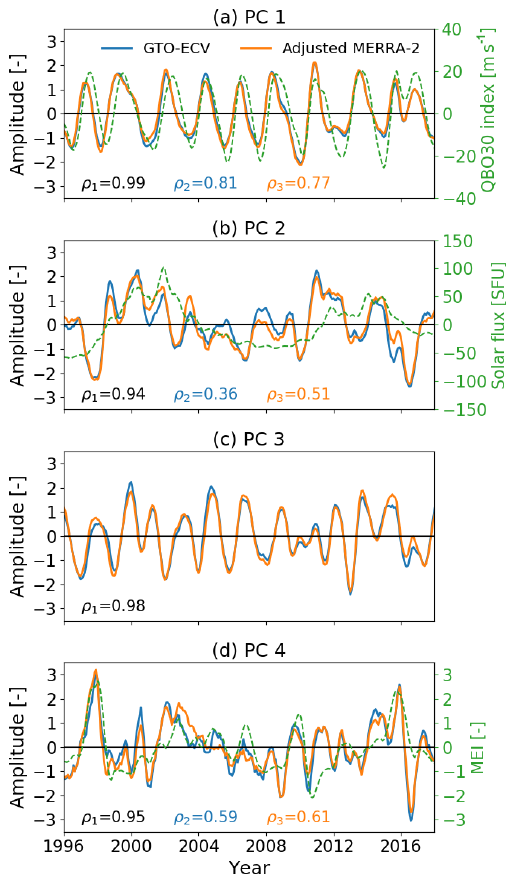
Figure 15. Fourier spectra of the first four principal components (shown in Fig. 14). From top to bottom: PC1, PC2, PC3, and PC4. Blue lines show GTO-ECV, and orange lines show adjusted